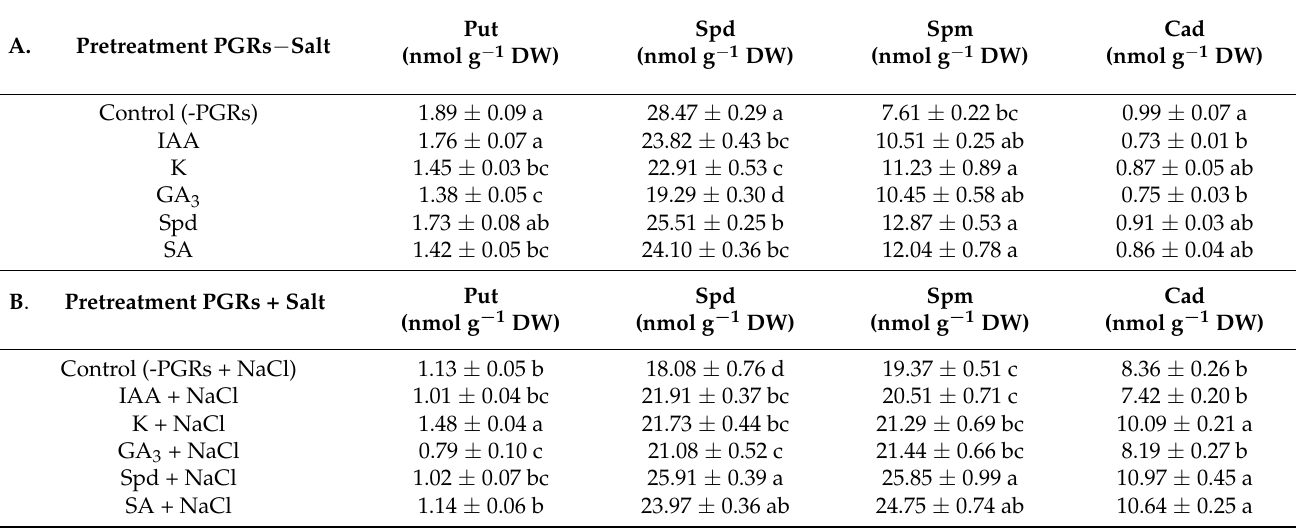
Table 3. ( A ). Effect of pretreatment PGRs − salt, and ( B ) PGRs + salt (300 mM NaCl) in F. pulverulenta leaves, at 52 days of culture, on free PAs content: putrescine (Put), spermidine (Spd), spermine (Spm) and cadaverine (Cad). The values represent means ± SE ( n = 4). Different letters next to columns represent significant differences among treatments, according to Tukey’s test ( p ≤ 0.01).